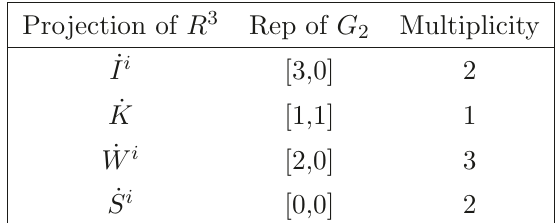
3 R in δψ . In each case, the index i runs over the corresponding ⊗